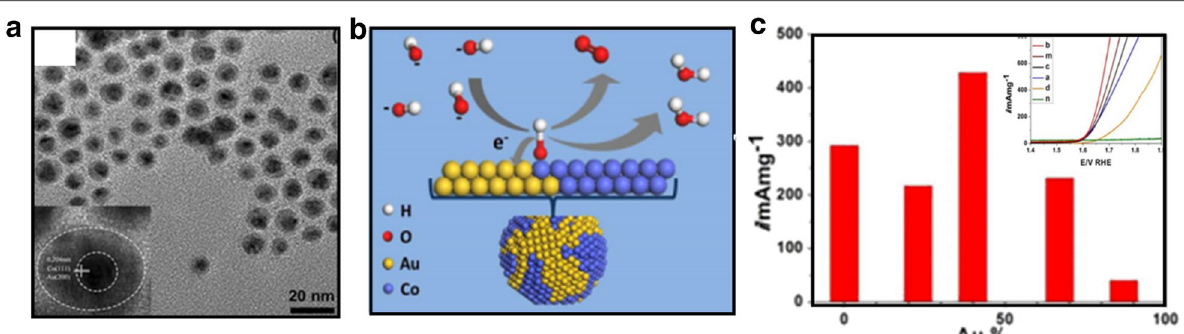
Fig. 13 a TEM images of AuCo core–shell nanoparticles (inset: high‑magnification TEM showing the lattice fringes corresponding to fcc Au and fcc Co), b schematic illustration of OER on the partially phase segregated AuCo nanoparticles, c comparison of catalytic activities at 1.67 V in 0.1 M KOH. Inset: polarization curves of (a) Au 23 Co 77 /C, (b) Au 40 Co 60 /C, (c) Au 71 Co 29 /C, (d) Au 95 Co 5 /C, (m) CoO x /C, (n) Au/C in 0.1 M KOH (Figure reprinted with permission from Ref.